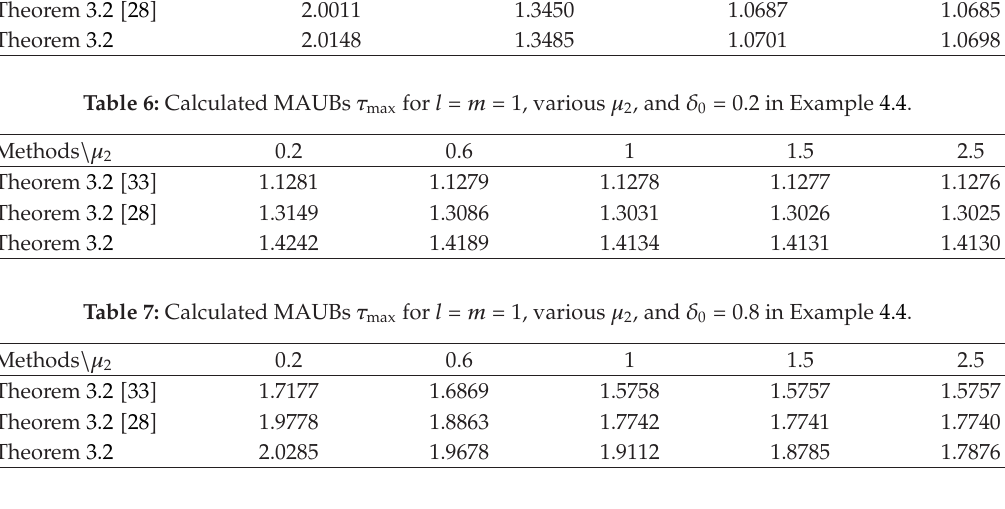
(cid:8) 2 ,μ max for l 2 in Example 4.3.